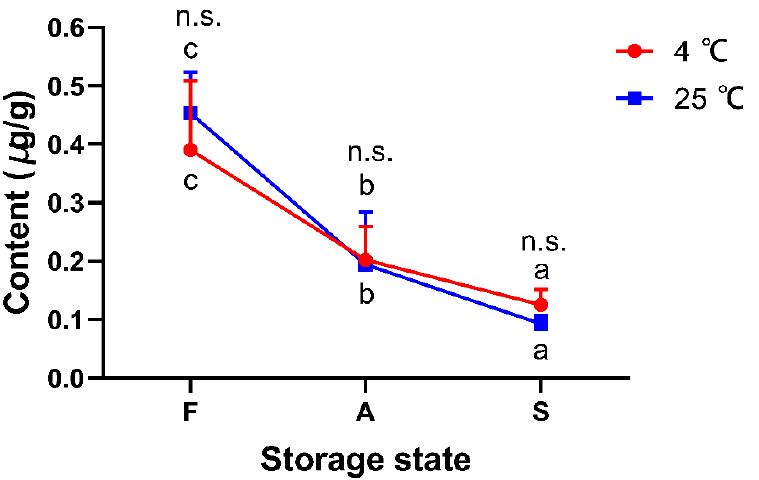
Figure 6. Changes in the content of peptide MVHMASKE in pork sampled from three markets in Nanjing under storage at 4 °C and 25 °C. F, fresh state; A, accelerated spoiled state; S, spoiled state. The different letters (a – c) indicate significant differences between different storage states at the same temperature ( p < 0.05). n.s. indicates no significant differences between two temperatures at the same storage state ( p > 0.05).